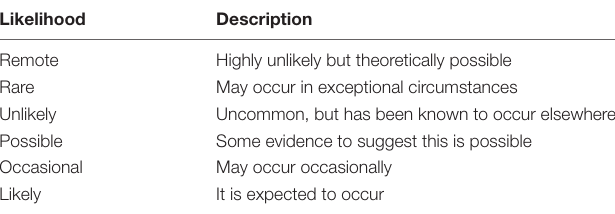
TABLE 4 | Likelihood of occurrence level with description. Adapted from Fletcher